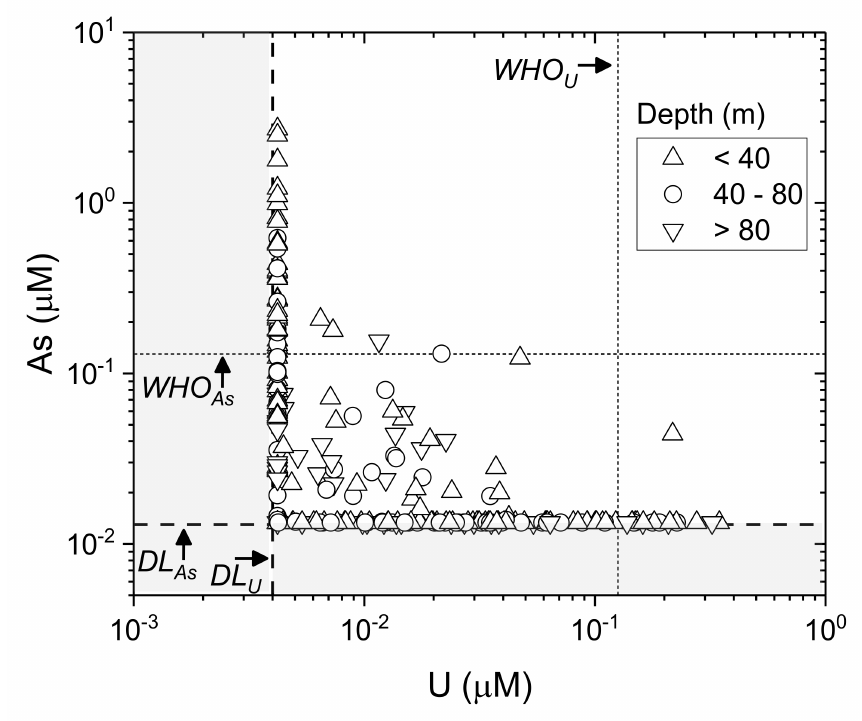
Figure 7. As versus U on a log-scale across the entire field area with WHO provisional guidelines [4] for As (0.13 µ M; 10 µ g.L − 1 ) and U (0.13 µ M; 30 µ g.L − 1 ) in dotted lines (WHO). Samples with measured concentrations below detection for a particular analyte are shown as maximum concentration at method detection limit (DL, shown in dashed lines). Grey boxes emphasize concentrations below method detection